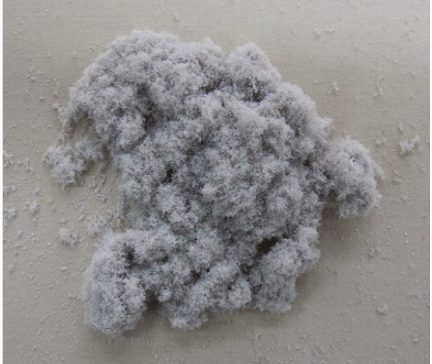
Figure 4: Paper fi bre.